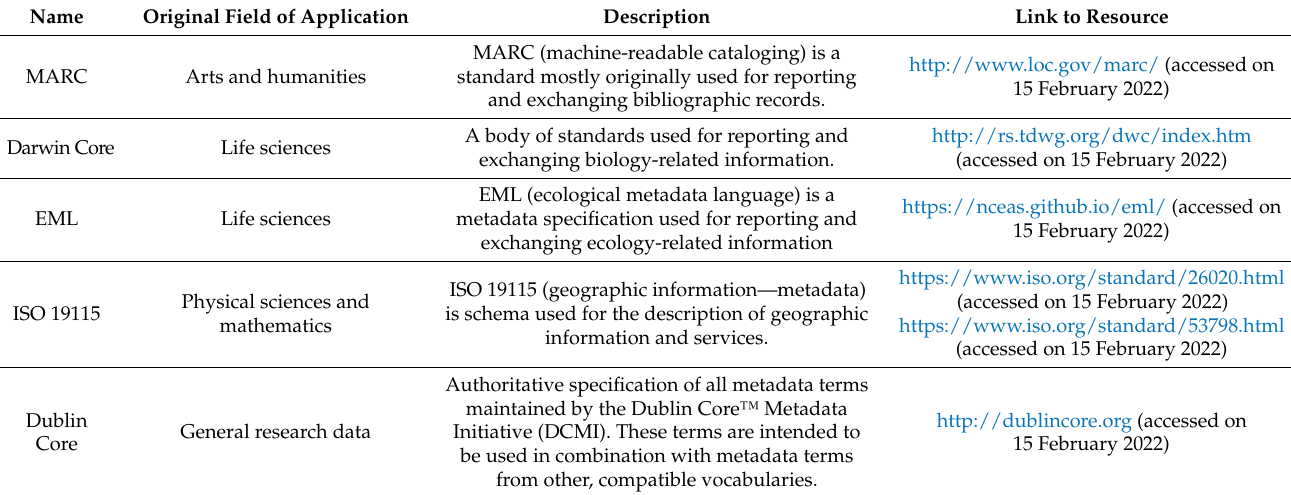
Table A1. Extract of commonly used metadata standards [35].